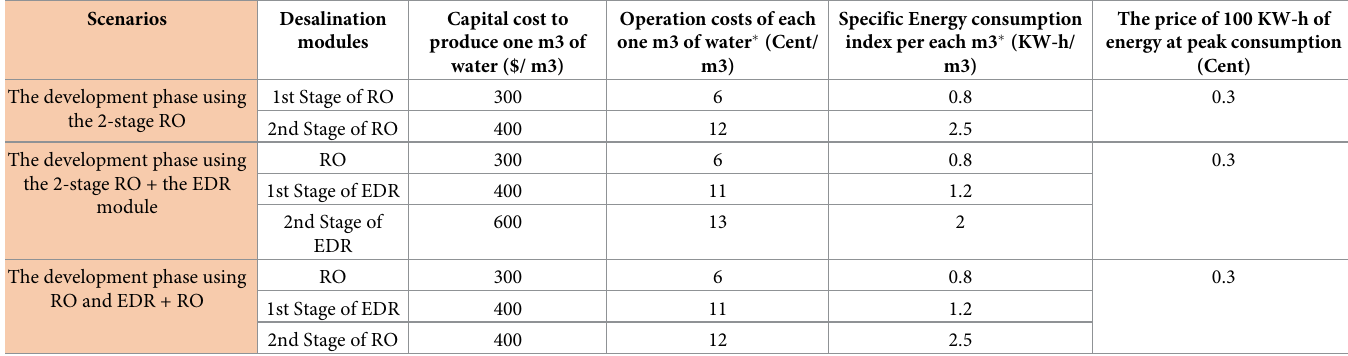
Table 7. The CAPEX & OPEX and price of electrical energy consumption of each scenario (1USD = 300,000 Iranian Rials). Scenarios